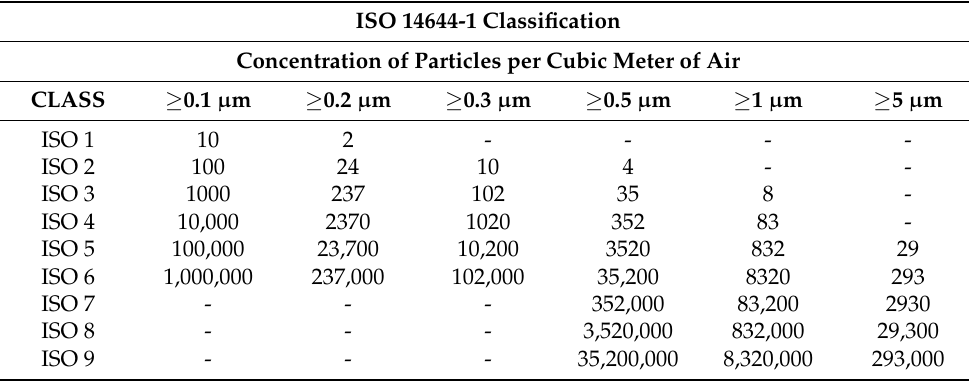
Table 2. Non-viable particle counts. ISO: International Organization for